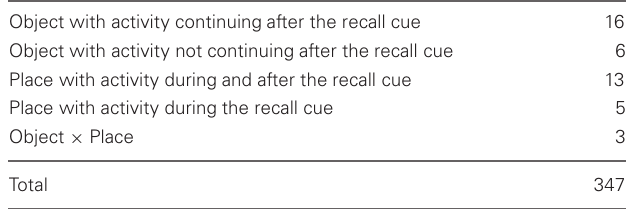
Table 1 | Numbers of neurons in the hippocampus with different types of response during the object-place recall